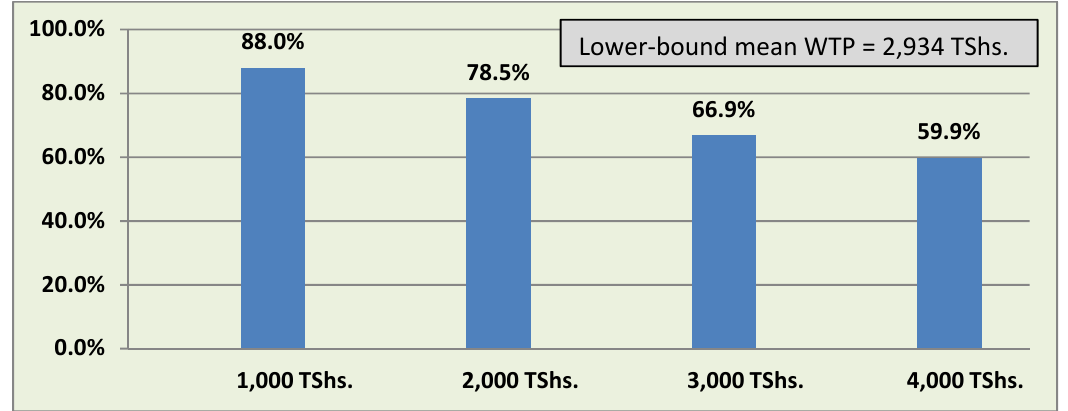
Figure 1. Willingness to pay for a larviciding program, by contribution amount per three-month period